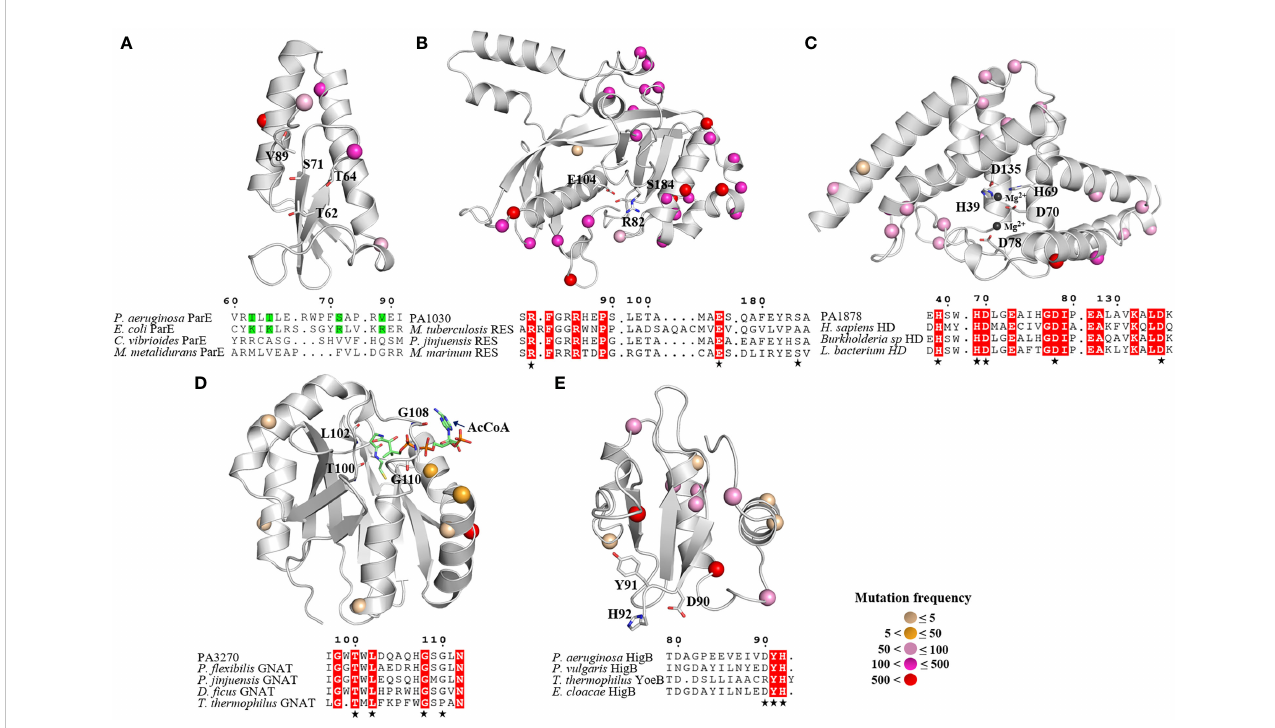
FIGURE 2 Overall structures of fi ve toxins and their conserved catalysis motifs. (A) ParE, (B) PA1030, (C) PA1878, (D) PA 3270 and (E) HigB. The 3D structure models of PA1030, PA1878 and HigB are obtained from AlphaFold, whereas the structures of ParE (6XRW) and PA3270 (1YRE) are obtained from RCSB PDB. The mutant sites of toxins from isolates are labeled in sphere style, and the different colors represent mutation frequency. (A) Sequence alignment of the P. aeruginosa ParE, E coli ParE, Caulobacter vibrioides ParE and Mesorhizobium metalidurans ParE (B) Sequence alignment of the PA1030, M. tuberculosis Rv1989c, Pseudomonas jinjuensis A0A1H0AAW9, Methylocaldum marinum A0A250KUB3. (C) Sequence alignment of the PA1878, Homo sapiens HDDC2, Burkholderia sp A0A3N8LA50, and Lachnospiraceae bacterium A0A1H3YLD1. (D) Sequence alignment of PA3270, Pseudomonas jinjuensis A0A1H0A919, Pseudomonas fl exibilis A0A0B3C4T8, Deinococcus fi cus A0A221ST89, Thermus thermophilus Q5SHD1. (E) Sequence alignment of P. aeruginosa HigB, P. vulgaris HigB, Thermus thermophilus YoeB, Enterobacter cloacae HigB. The catalytic residues are indicated as sticks in secondary structure and highlighted (asterisk) in sequence